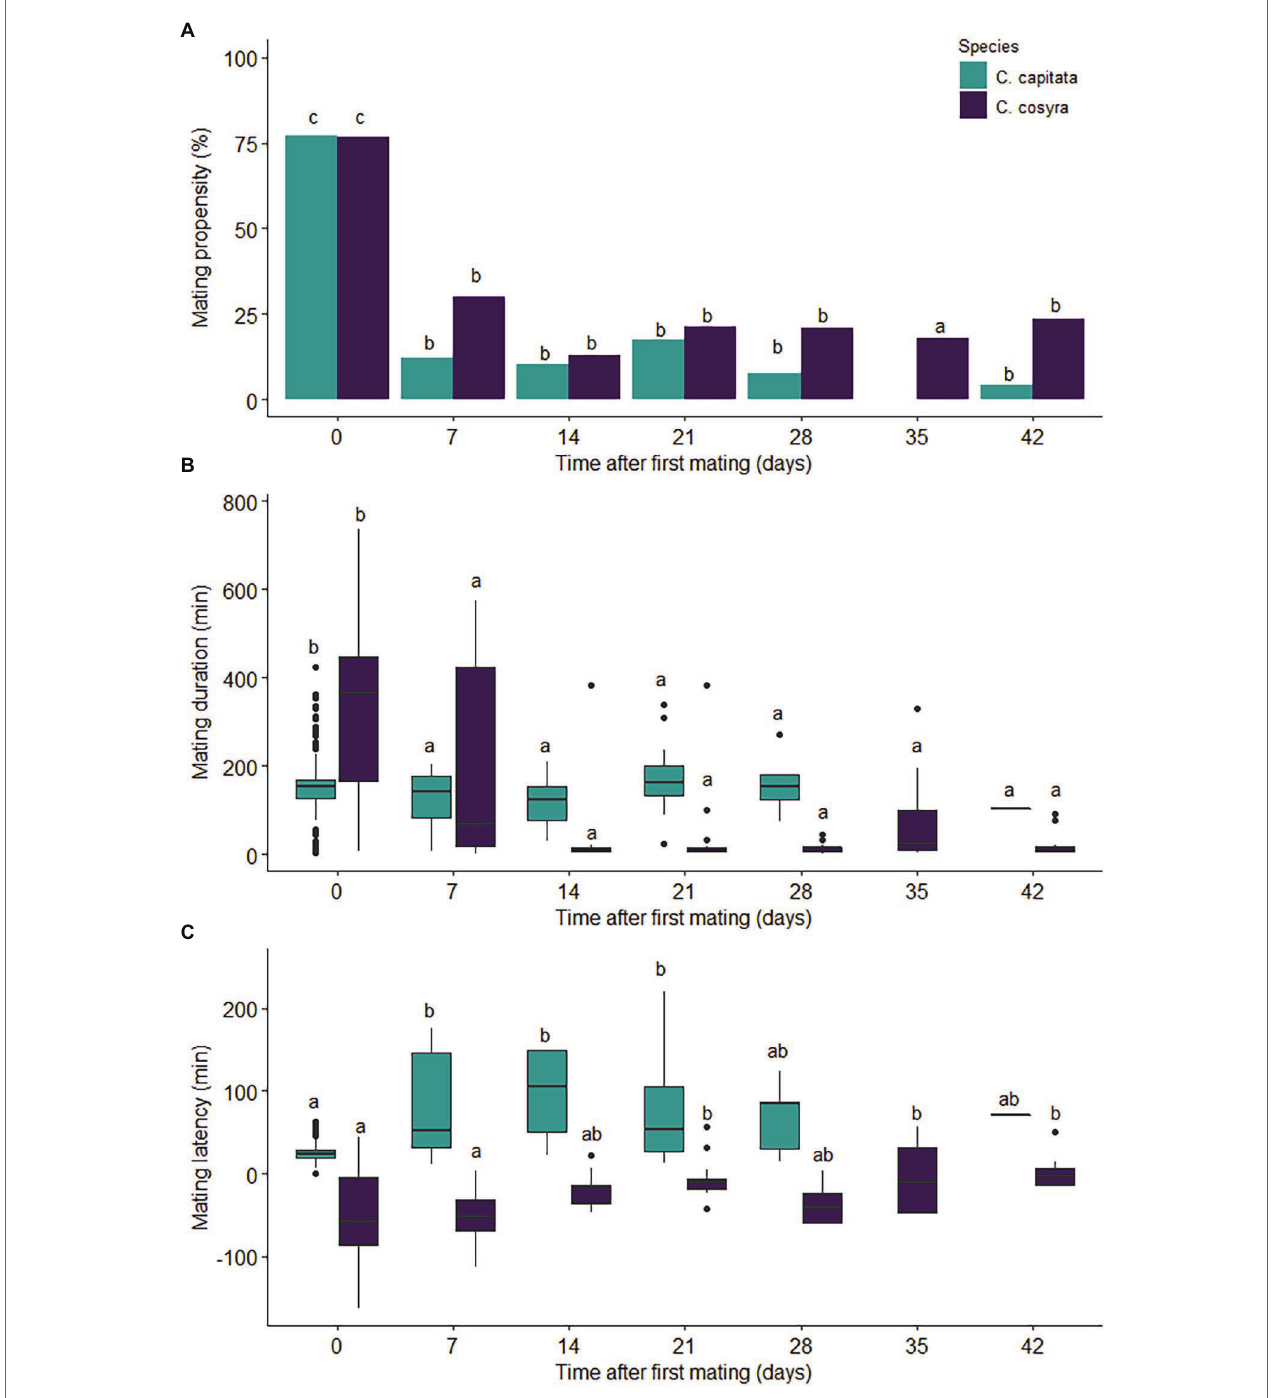
FIGURE 1 | Mating behaviour of C. capitata ( n = 97) and C. cosyra ( n = 93) females kept individually in containers and given weekly remating opportunities with a virgin male of peak reproductive age. The values displayed are the (A) mating propensity, (B) mating duration and (C) mating latency of remated pairs. Time intervals within species with the same lowercase letter are not significantly different (Tukey’s HSD post-hoc tests, α =